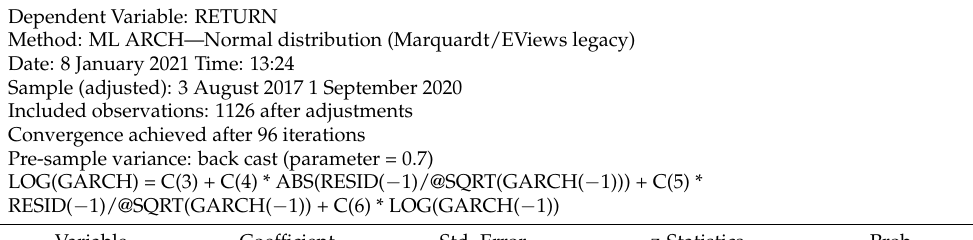
Table 11. Estimated Result of E-GARCH Model for Saudi Riyal Return Index during